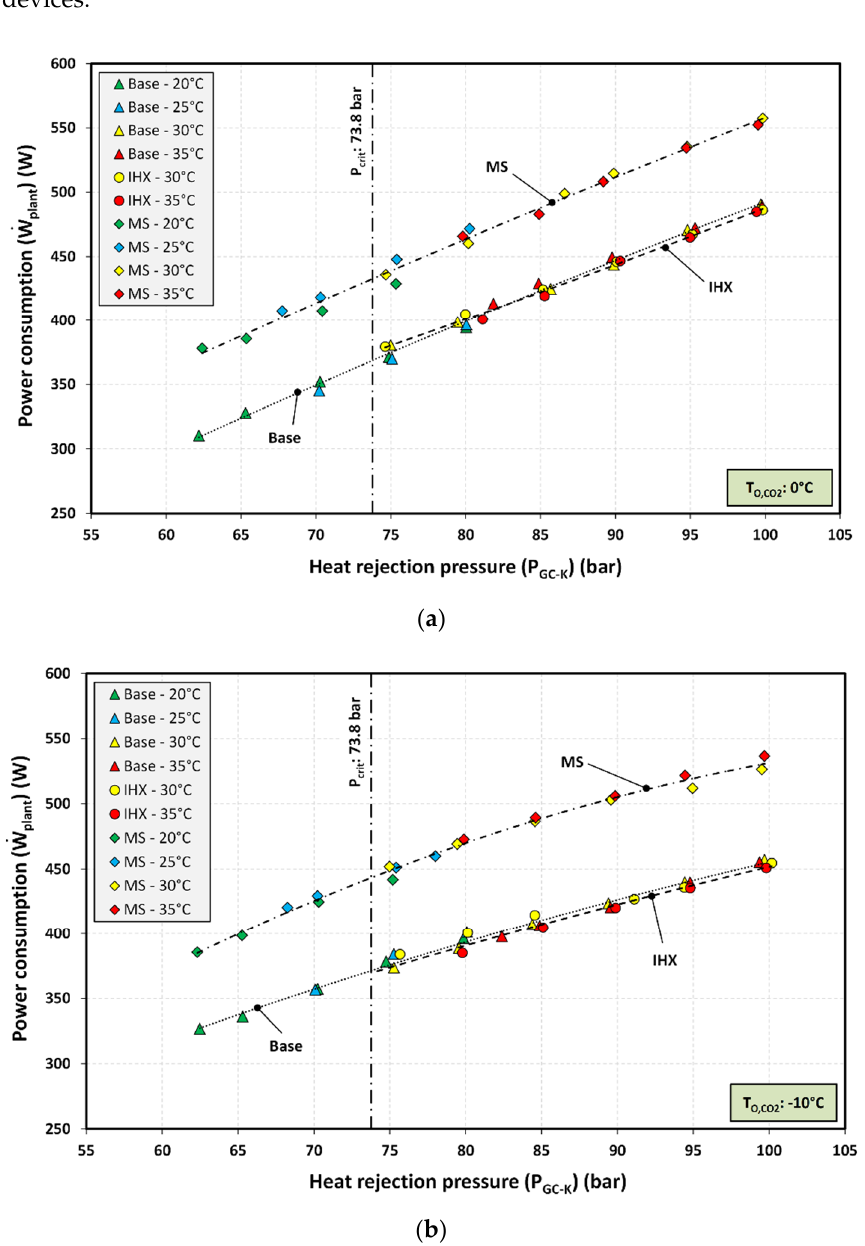
. W plant ) of the refrigerating plant at 0 ◦ C ( a ) and − 10 ◦ C ( b